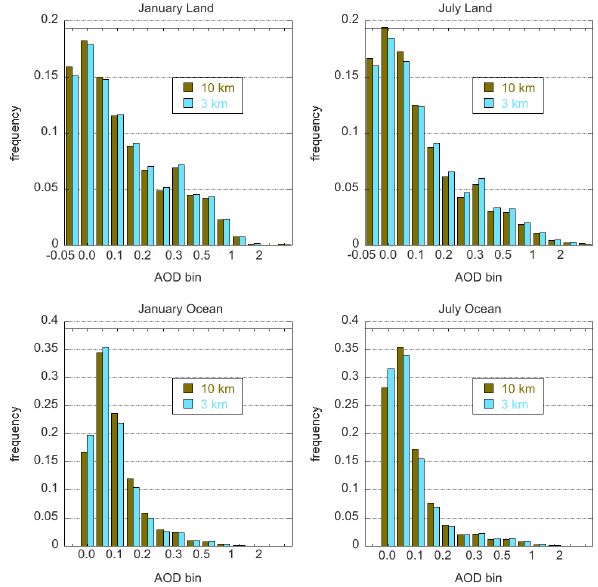
Fig. 9. Frequency histograms of 10km and 3km AOD retrievals, constructed from global retrievals from three months of January (2003, 2008 and 2010) in the left column and from three months of July (same years) in the right column. Land in the top row and ocean in the bottom. Bin labels represent the lower boundary of the bin. Note a scale break in the x axis. Bin widths below 0.3 are 0.05. Above 0.3, widths increase and are variable: 0.3 to 0.4, 0.4 to 0.5, 0.5 to 0.7, 0.7 to 1.0, 1.0 to 1.5, 1.5 to 2 and 2 to 3.